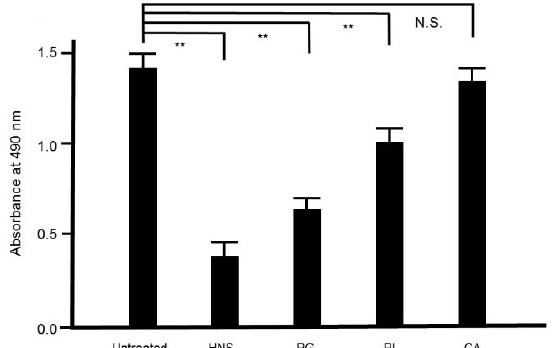
Figure 9. Inhibitory effects of the extracts of the crude drugs composed of the HNS on the biofilm formation by S. mutans . Bacteria were treated with the samples for 48 h, then stained with safranin red. The concentrations of the samples used were as follows: HNS, 500 μg/mL; and extracts of Platycodon Radix (PG), Paeoniae Radix (PL), and Aurantii Fructus Immaturus (CA), 127, 194, and 179 μg/mL, respectively. Data demonstrate the mean ± S.D. ( n = 6). **: p < 0.01 by Tukey’s multiple comparison tests. NS: not significant.